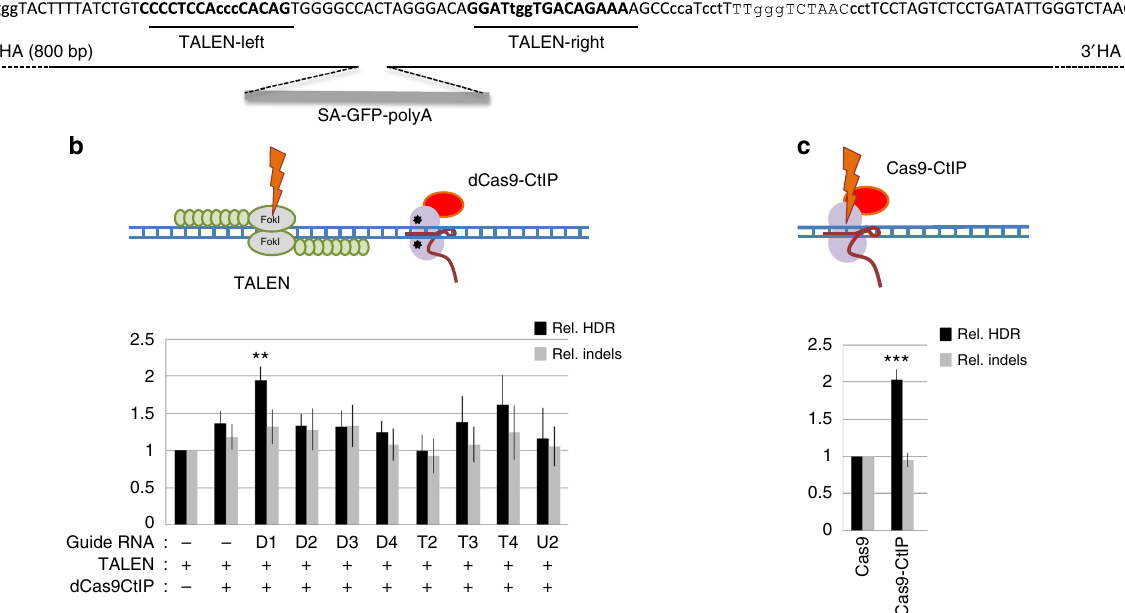
Fig. 1 Forcing CtIP recruitment to the DNA cleavage site stimulates targeted transgene integration. a Distribution of TALEN and guide RNAs at AAVS1 safe harbor locus. gRNAs are indicated on top of their corresponding PAM motif, which is shown as lowercase in the sequence. The donor DNA used had 5 ′ and 3 ′ homology arms as indicated. b Relative HDR and indel frequencies induced by TALEN and dCas9 – CtIP recruitment near the cleavage site using different guide RNAs. Human RG37 fi broblasts were transfected with the indicated plasmids and GFP transgene donor with homology arms to the targeted AAVS1 locus. HDR-mediated transgene integration was measured by FACS analysis of GFP-positive cells resulting from targeted GFP transgene integration. Indels at the cleavage site were measured by the T7E1 assay. The results are expressed as the mean of relative HDR or indel frequencies calculated by normalizing HDR or indel frequencies by that induced by TALEN transfection alone. Asterisks indicate the difference that is statistically signi fi cant when comparing cotransfection of dCas9 – CtIP, guide RNA, and TALEN to TALEN-alone transfection in t -test (* P <0.05). Data are from three independent experiments. Error bars indicate standard deviation. c Relative HDR and indel frequencies induced by Cas9 and Cas9 – CtIP at the cleavage site directed by T2 guide RNA. The results are expressed as the mean of relative HDR or indel frequencies calculated by normalizing HDR or indel frequencies by that induced by Cas9. Asterisks indicate that the difference is statistically signi fi cant when comparing Cas9 – CtIP to Cas9 in t -test (** P <0.005). Data are from three independent experiments. Error bars indicate standard deviation. Guide RNA T2 was used because in contrast to other guides, it did not cleave the donor DNA